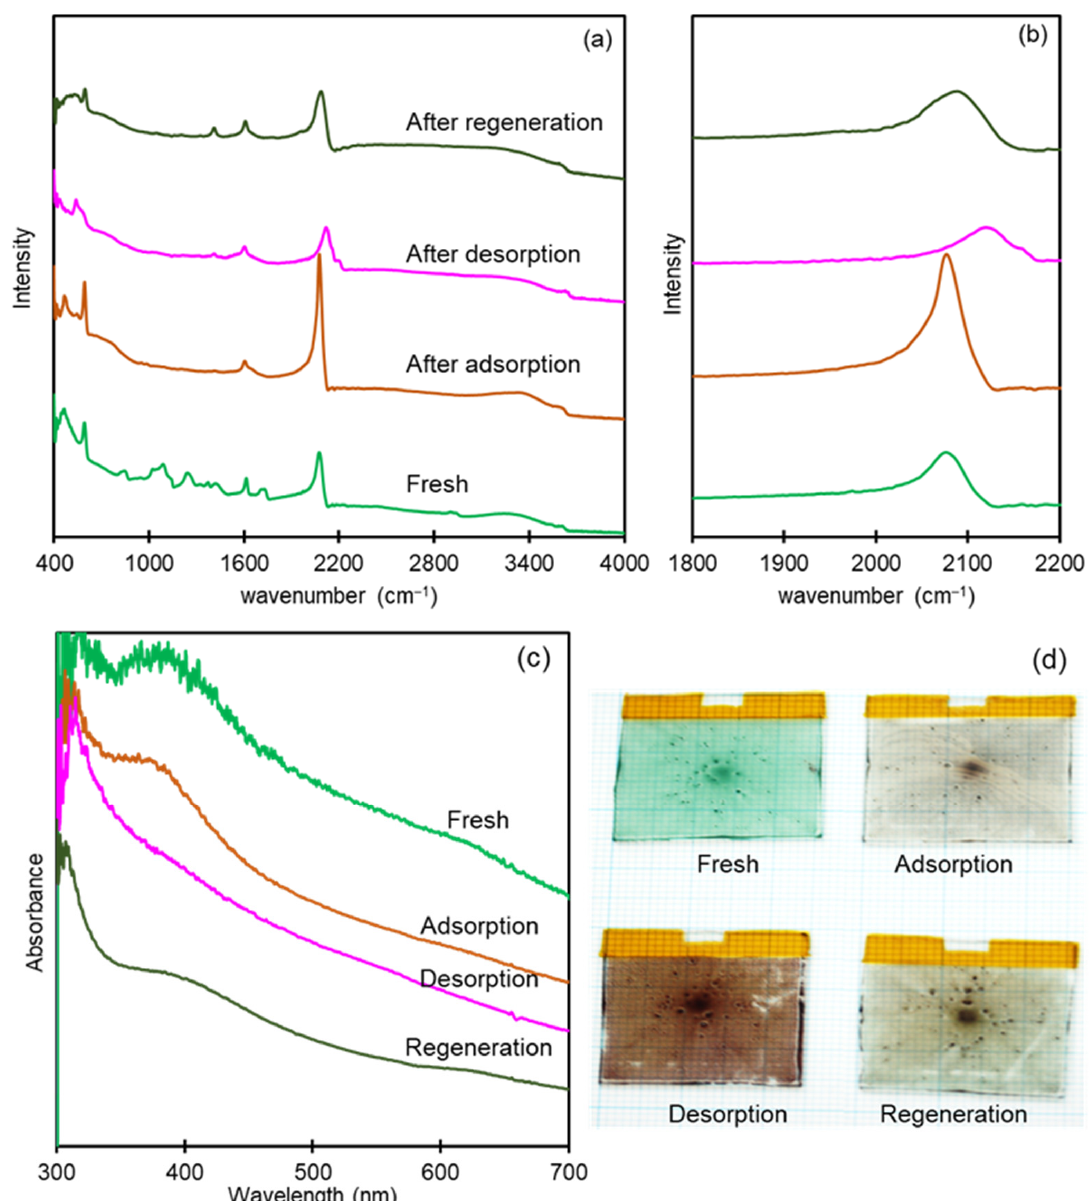
Figure 5. Characterization of CoHCF thin film during each step of the adsorption-desorption-regeneration cycle. ( a , b ) FTIR spectrum, ( c ) UV-vis spectrum, and ( d ) photographs of CoHCF thin films at fresh state, after adsorption, desorption, and regeneration.